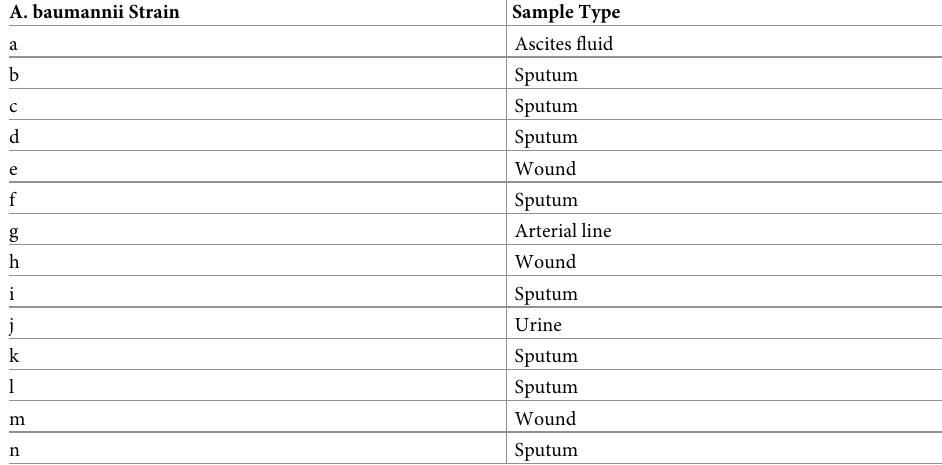
Table 1. Distribution of A . baumannii isolates based on sample